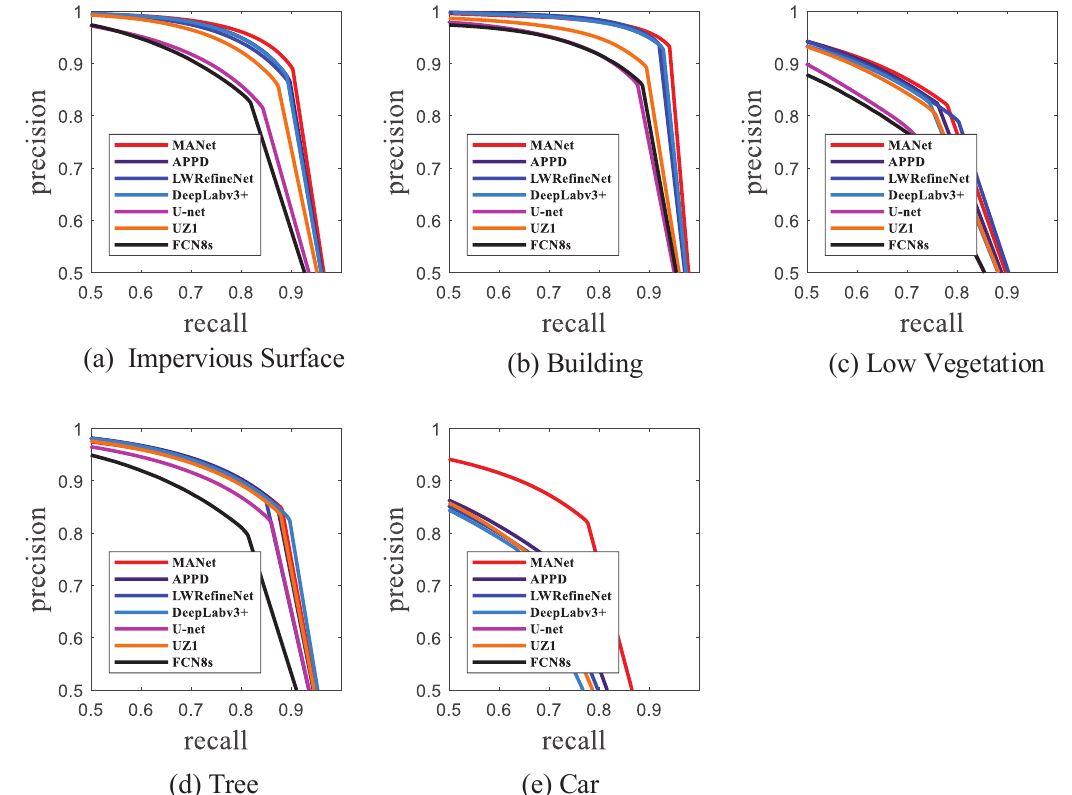
Figure 7. PR curves for each category of the seven models on the Vaihingen dataset.